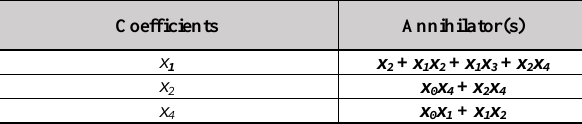
Table 6 : Output of annihilator(s) (above).